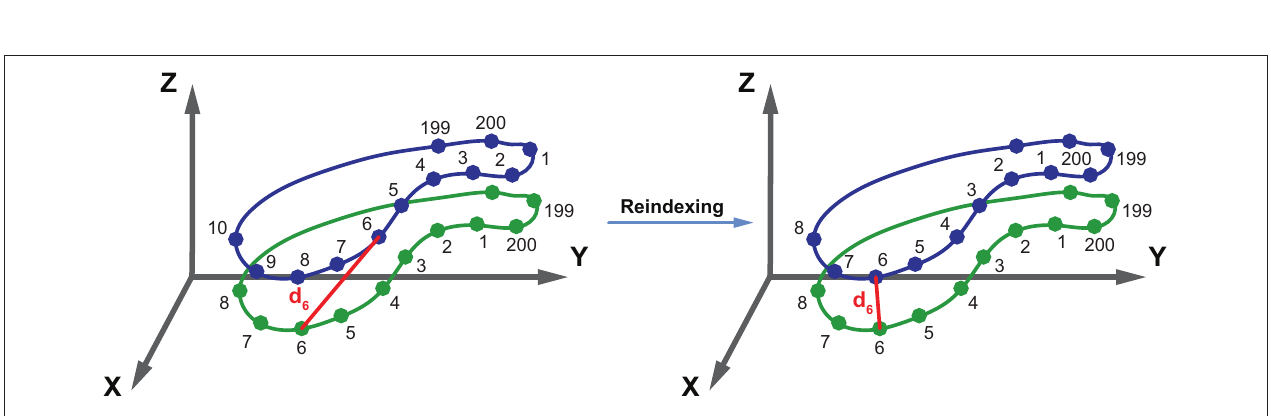
FIGURE 4 | Schematic illustration of the CMRI-based reconstruction algorithm. After the end-diastolic and end-systolic cardiac phases were identified, the epi- and endocardial layers were manually traced in cine short-axis images. Then, the endocardial contours of the right ventricle were exported to separate files as a series of 2D point coordinates. These files were supplied into a 3D mesh reconstruction pipeline that comprises four consecutive steps: (i) preprocessing contour data, (ii) creating 3D point clouds from contour data, (iii) reindexing the vertices in the 3D point clouds, and (iv) fitting closed surfaces to the 3D point clouds. See text for further details. CMR, cardiac magnetic resonance; RV, right ventricle.